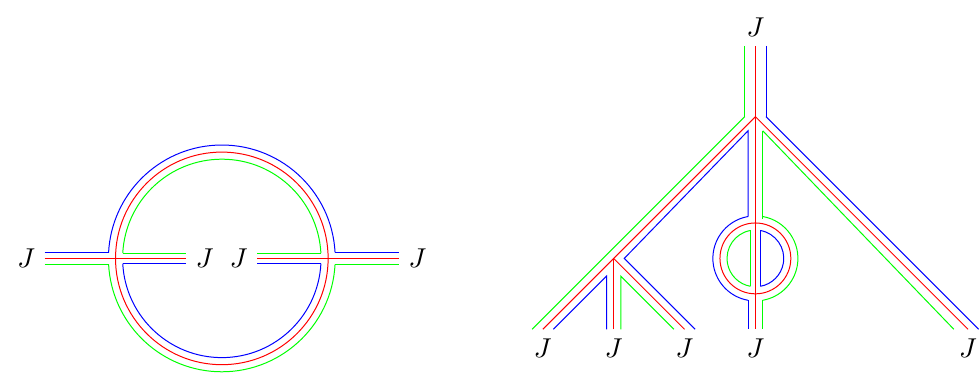
Figure 2 . On the left is an example of a planar diagram that is subleading in the large N limit (1.4). On the right is an example of the melonic tree diagrams that dominate in this